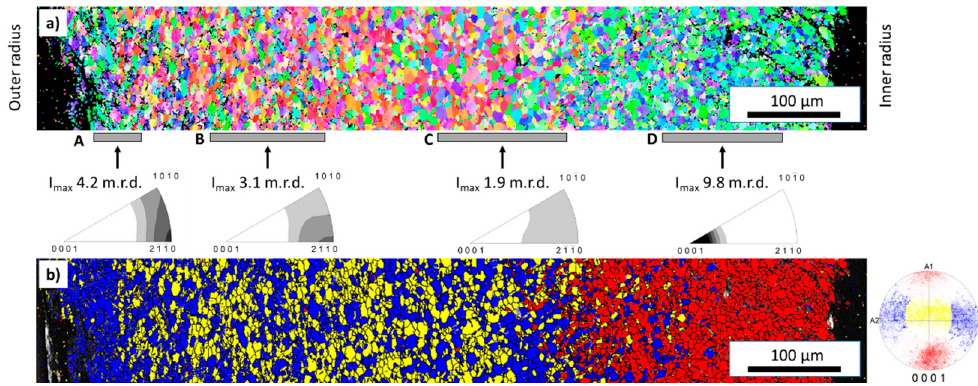
Figure 5. ( a ) Grain and orientation map of a cross section from a wrapped section of an AZ31 wire (thickness 1 mm) wrapped along a core with 2 mm diameter; outer radius is left, and inner radius in right. Sections are cropped for local inverse pole figure presentation along the extrusion direction (vertical): (A) outer surface, (B) tensile strain affected zone, (C) transition to compressive strain affected zone, and (D) inner surface; ( b ) same picture with highlighted grain orientations as labelled in the discrete (0001) pole figure.